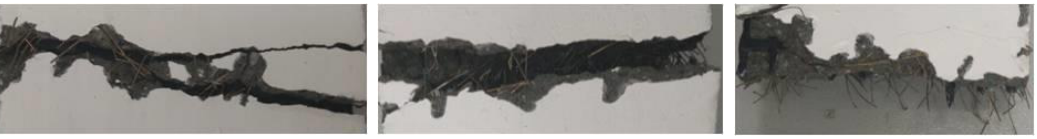
Figure 18. Bridging effect of the steel fibres at the cracks.